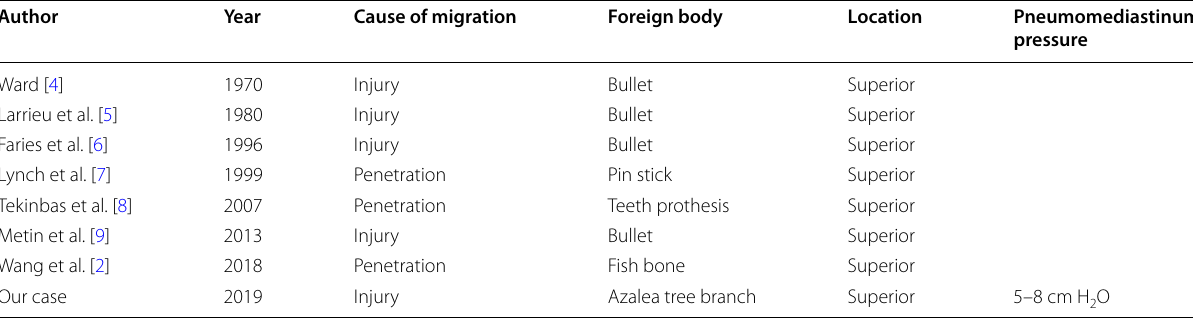
Table 1 Characteristics of seven case reports and the present